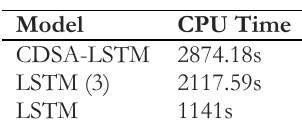
Table 5. CPU time of train